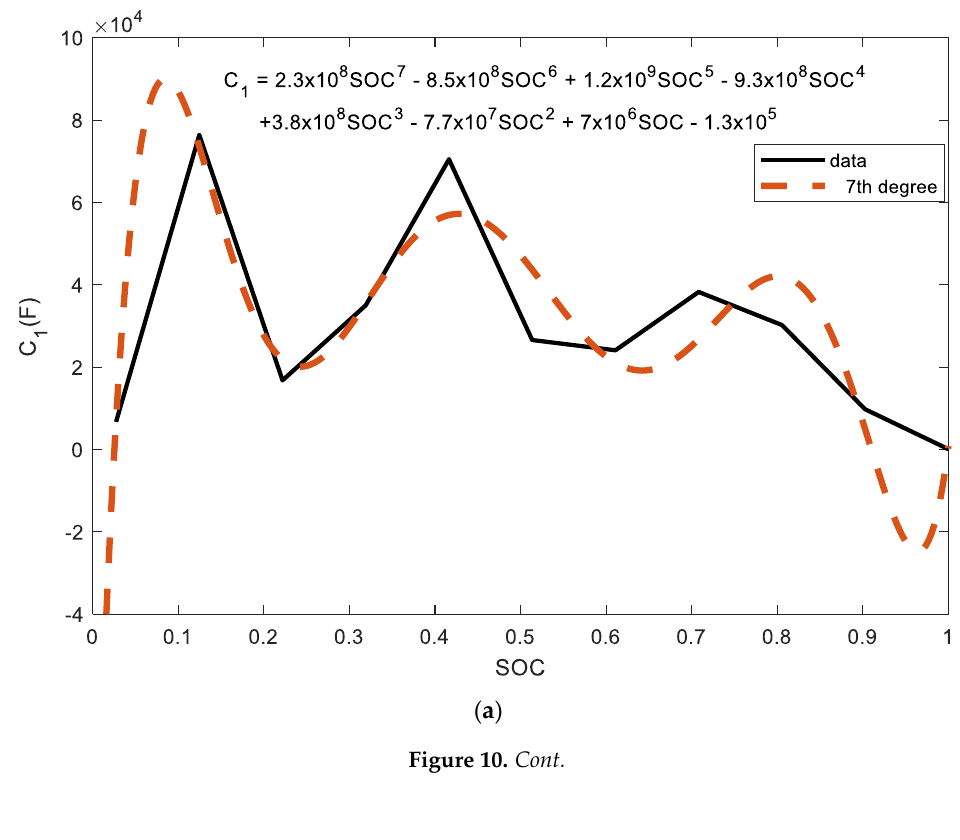
Figure 9. R 1 as function of ( a ) SOC ; ( b ) SOC and ambient temperature.